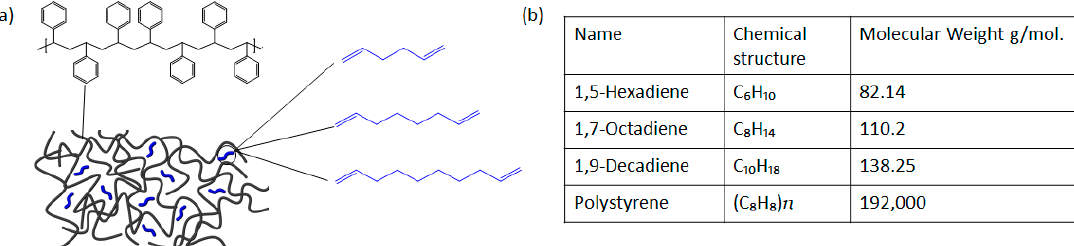
Figure 1. Polystyrene plasticizing and plasticizers. ( a ) Schematic of plasticized polystyrene ( b ) Chemical structure and details of polystyrene and plasticizers.